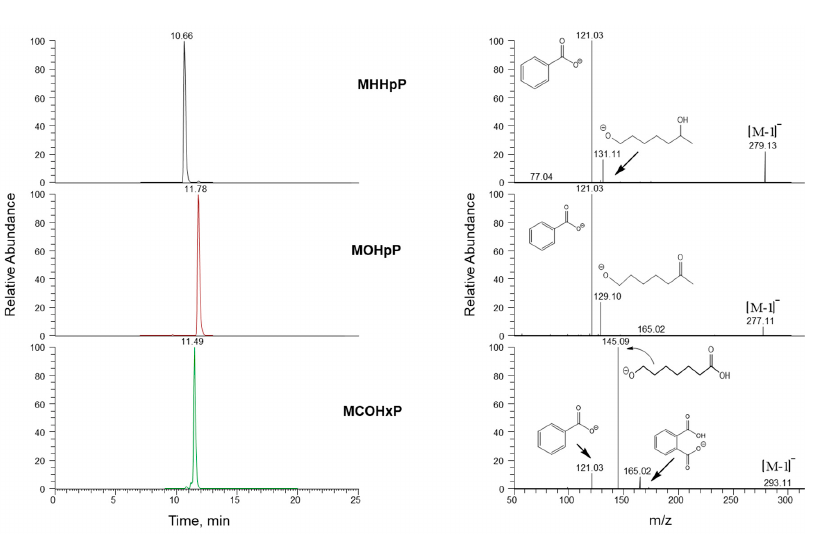
Figure 2. Chromatographic separation and mass spectra of diisoheptyl phthalate metabolites. Table 1. Analytical parameters for the quantification of diisoheptyl phthalate metabolites.